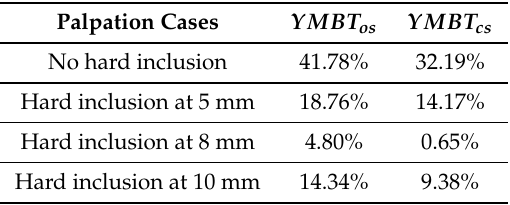
Table 3. YM bias term (YMBT) during the robotic palpation